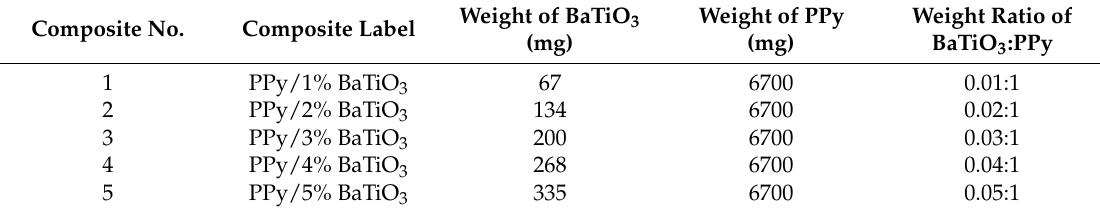
Table 1. Amounts of BaTiO 3 and PPy in the composites